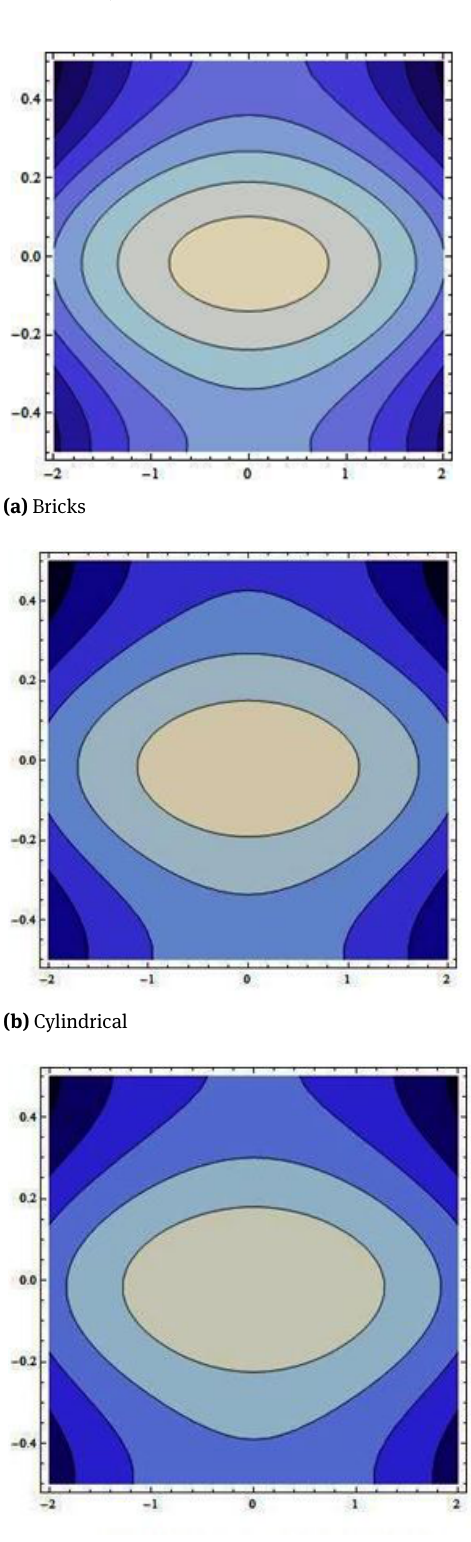
Fig. 6: (a) Velocity profile for various values of shape factor (b) Tem- perature profile for various values of shape factor (c) Pressure gradi- ent for various values of shape factor Fig. 7: Effect of various shapes of the shape